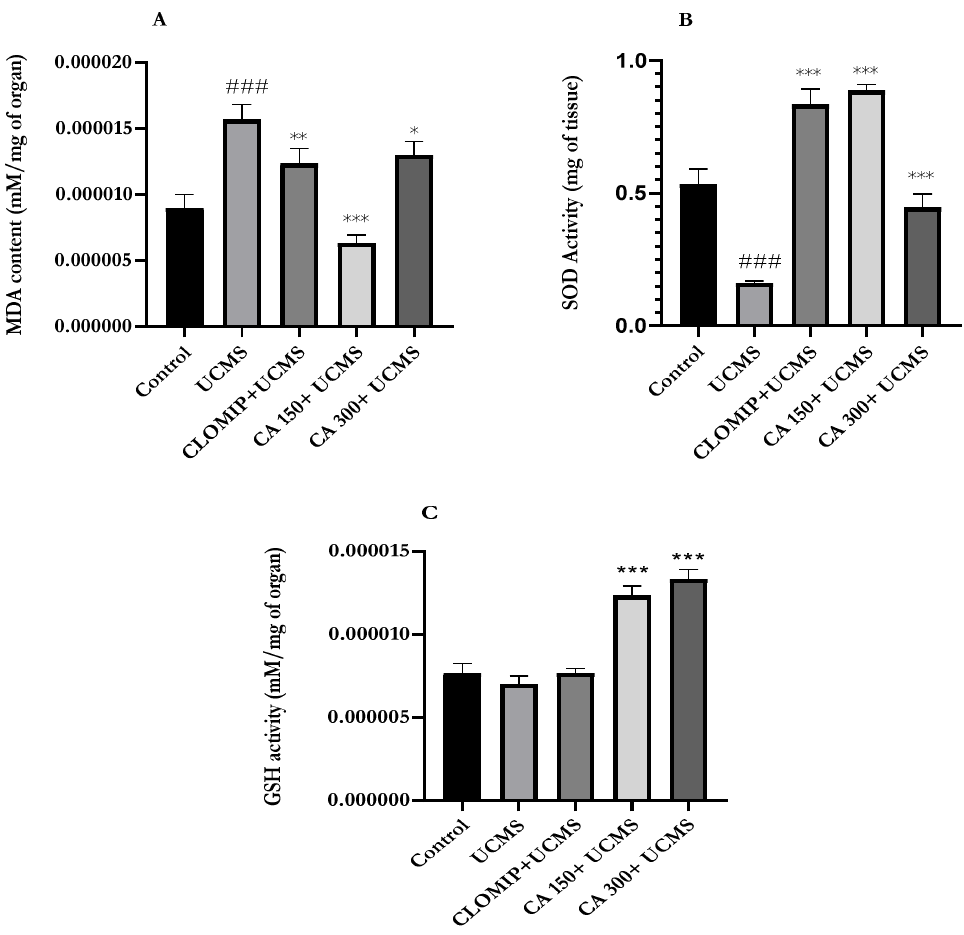
Figure 4. Effects of DCM/MeOH extract of C. adansonii on MDA concentration (A), SOD activity (B) and GSH concentration (C) in the hippocampus of mice after 30 days of treatment Each bar represents the mean ± MSE, UCMS: chronic mild unpredictable stress; CLOMIP + UCMS: positive control receiving clomipramine (20 mg/kg); CA + UCMS: animals receiving the DCM/MeOH mixture extract (v/v: 1/1) of C. adansonii at doses of 150 and 300 mg/kg. *** p < 0.001 compared to UCMS group. ### p < 0.001 compared to the normal